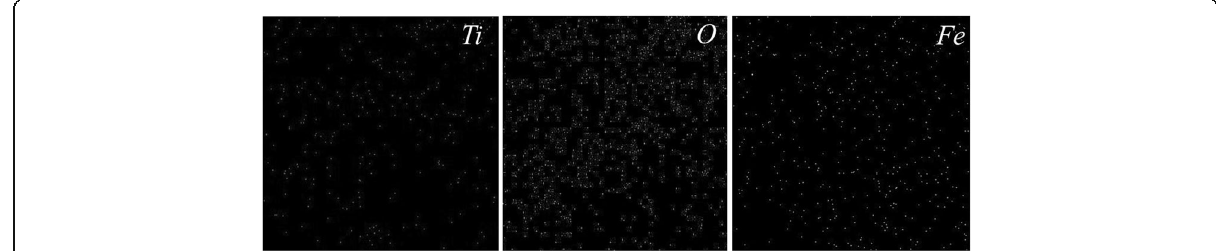
Fig. 6 K α X-ray mapping of Fe, O, and Ti over the surface of N/Fe x Ti y O z film treated at 450